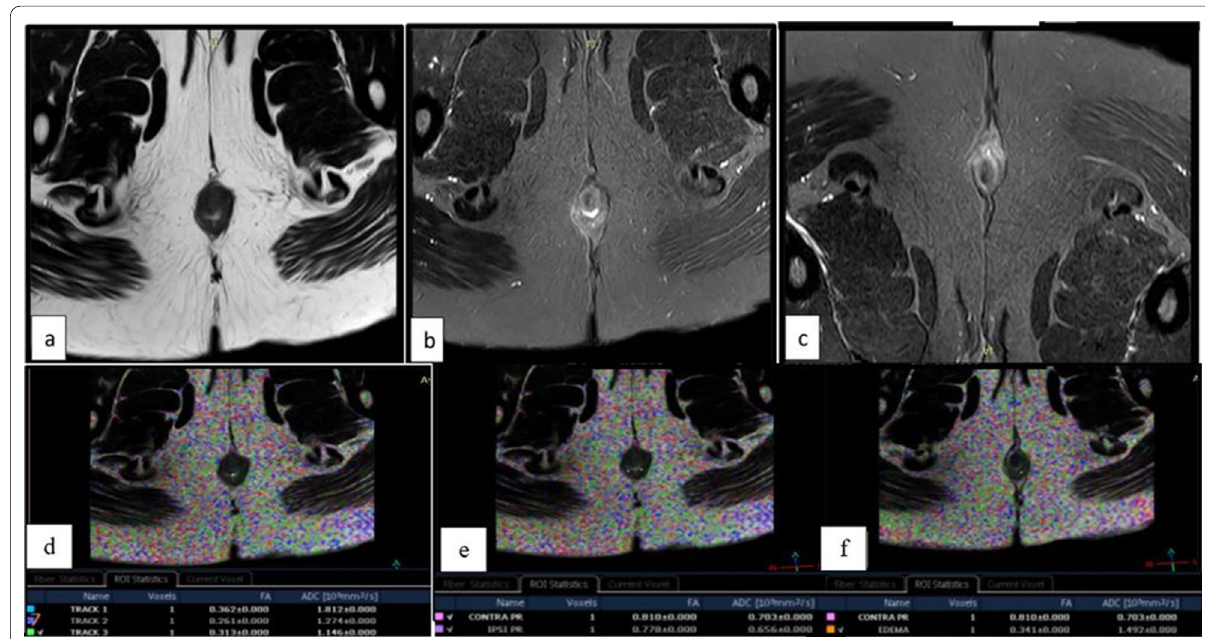
Fig. 2 a axial T2 WI, b axial STIR WI, c coronal STIR WI for an inter-sphincteric track of bright signal in T2 and STIR WI extending from 4 to 8 O’clock surrounding the internal sphincter. axial DTI/T2 fused images with ROI (FA and ADC) values placed in the inter-sphincteric track ( d ), ipsilateral and contralateral sphincters ( e ) and surrounding edema ( f ) with FA values 0.313, 0.778, 0.810 and 0.341 and ADC values 1.146, 0.656 and 0.703, 1.492 10 3 mm 2 /s, respectively. The FA and ADC values are relatively low indicating active inflammatory